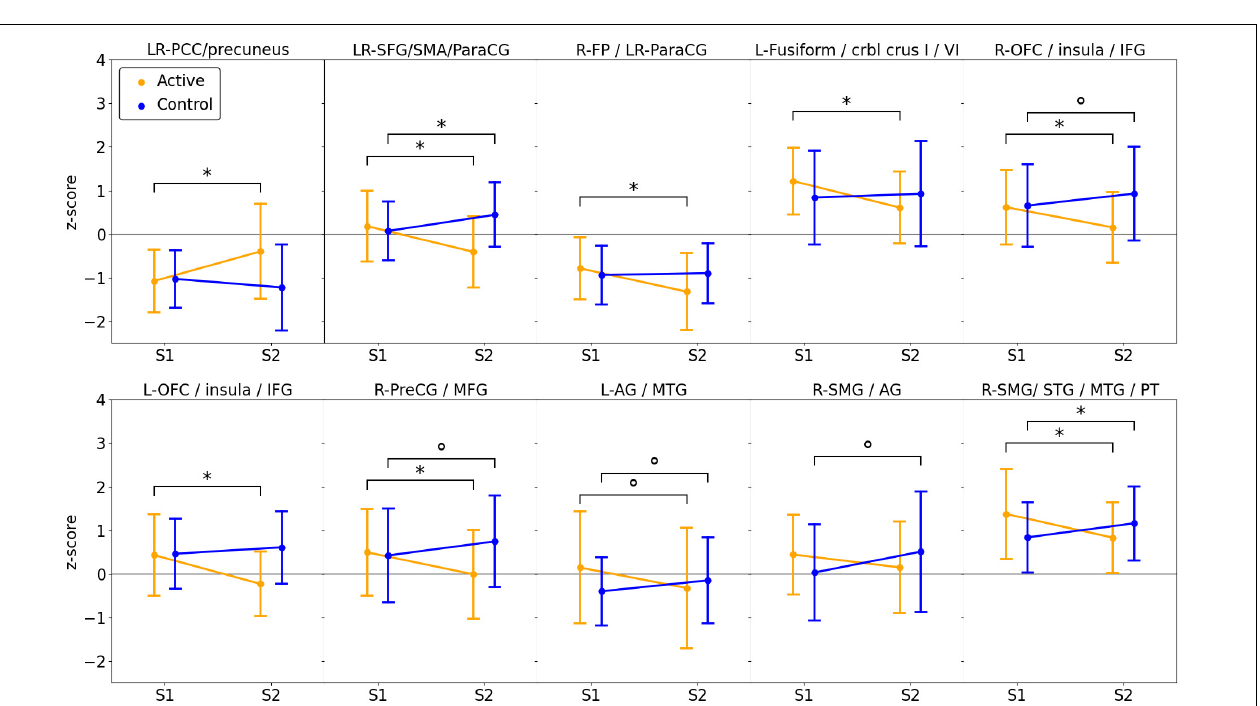
FIGURE 3 | Thresholded Statistical Parametric Maps for Post hoc Contrasts within the ROI Mask ( Figure 2D ). Orange: Clusters manifesting significantly greater activation difference over time for the Active group compared to the Control group (posterior cingulate/precuneus, inferior cerebellum). Blue: Clusters manifesting significantly smaller activation difference over time for the Active group compared to the Control group (see Table 1 for the list of clusters). Other conventions same as Figure 2 .